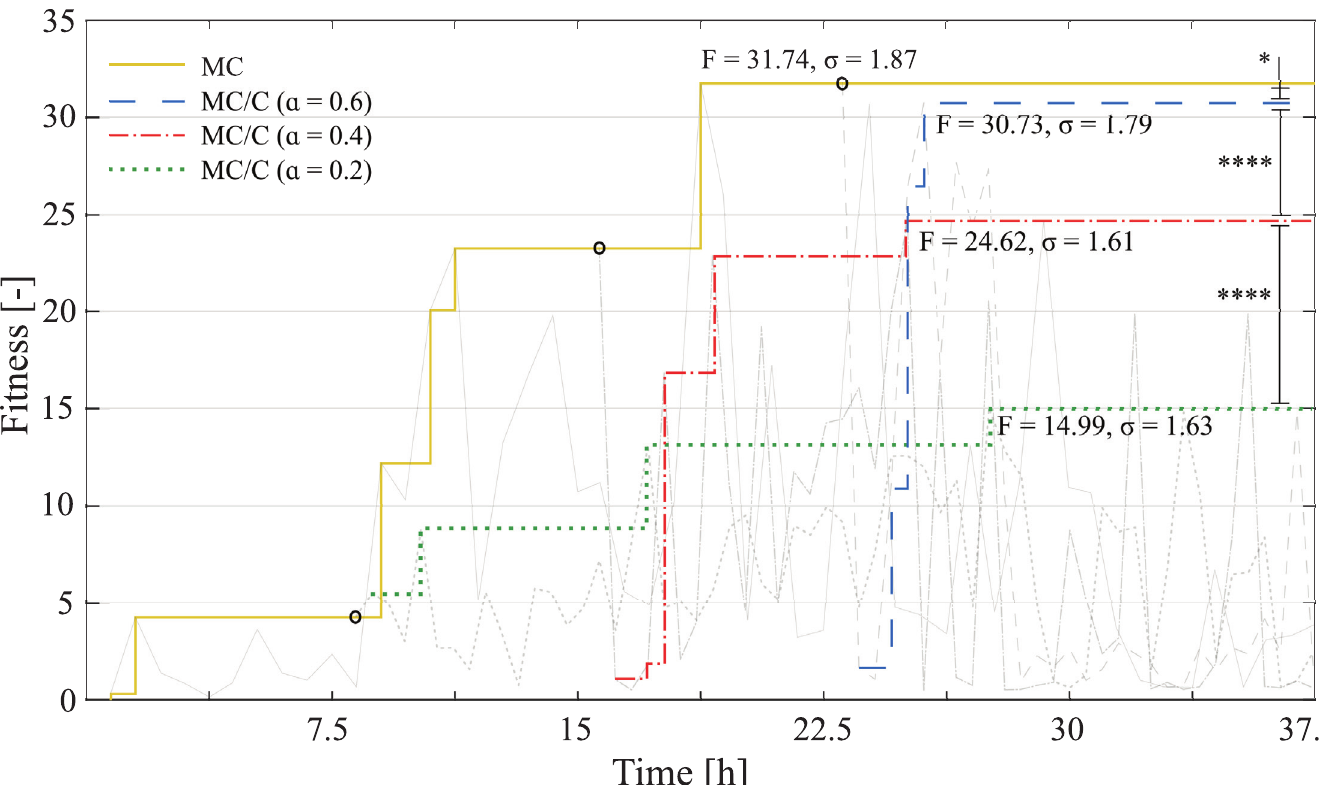
Fig 4. Superiority of MC over MC/C. The maximum fitness found after 37.5 hours of MC experiments is shownwith a yellow line. The C processes of ɑ = 0.2 (green), ɑ = 0.4 (red) and ɑ = 0.6 (blue) are shown with their initial seed depicted with a black circle. A post-hoc Tukey HSD test performed in the best result from each process shows statistical significance( **** ,p < 0.001,or * , p < 0.05)for all cases. The importance of a good morphologyis highlightedby the improvements observedfrom green to red and from red to blue. Still, the green, blue and red lines are alwaysbelow the values of the goldenline. Thus, the MC process is faster than the three C alternatives in finding better